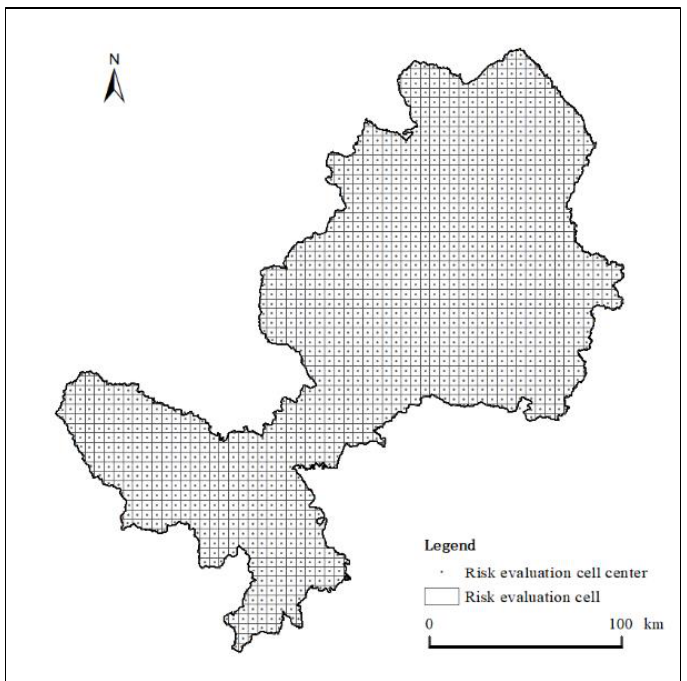
Figure 3. Grid division of EFZUYR ecological risk.